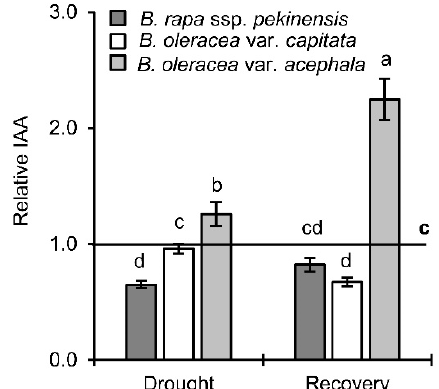
Figure 7. Level of indole-3-acetic acid (IAA) in Brassica crops under drought and recovery. Controls are normalized to the value 1. Columns marked with different letters are statistically significantly different ( p ≤ 0.05). Data are mean ± SD, n = 4. Raw data are presented in Supplementary Table S6.